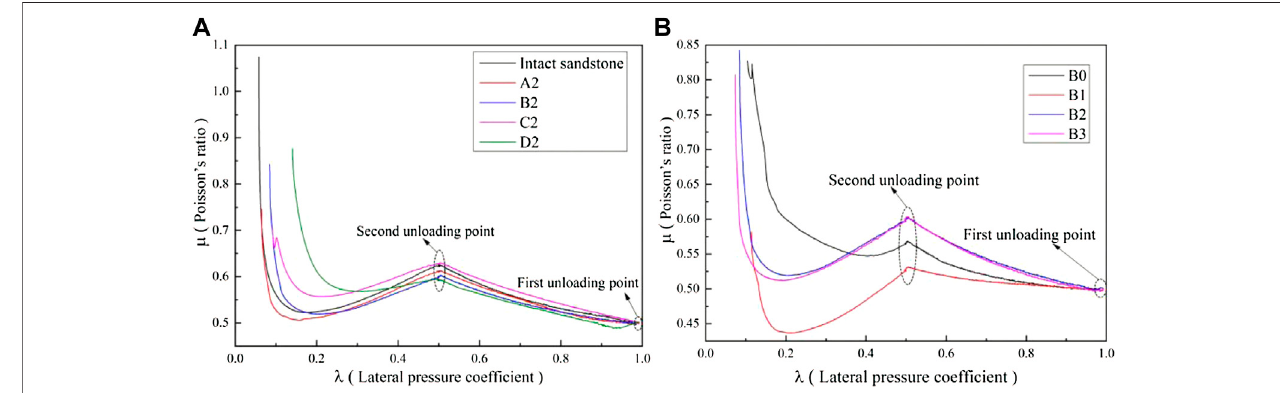
FIGURE 8 | Relationship between Poisson ’ s ratio ( μ ) and lateral pressure coef fi cient ( λ ) of the single-crack samples: (A) crack length (A2, 10 mm; B2, 15 mm; C2, 20 mm; D2, 25 mm); (B) crack angle (B0, 0 ° ; B1, 30 ° ; B2, 60 ° ; B3, 90 ° ).